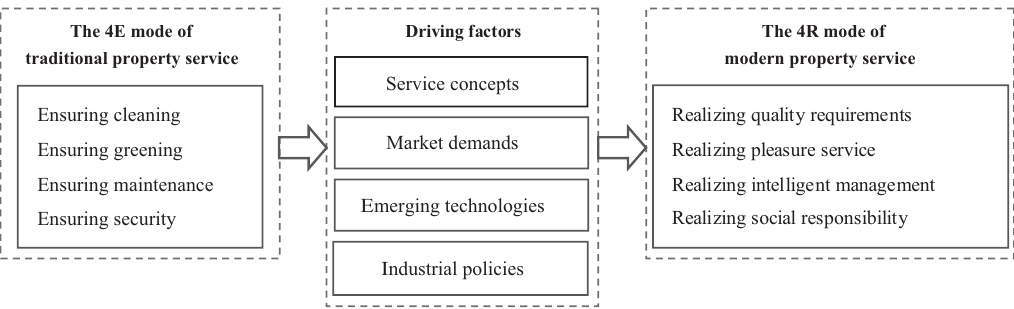
Figure 3. Driving factor analysis of the transformation and upgrading of the property service